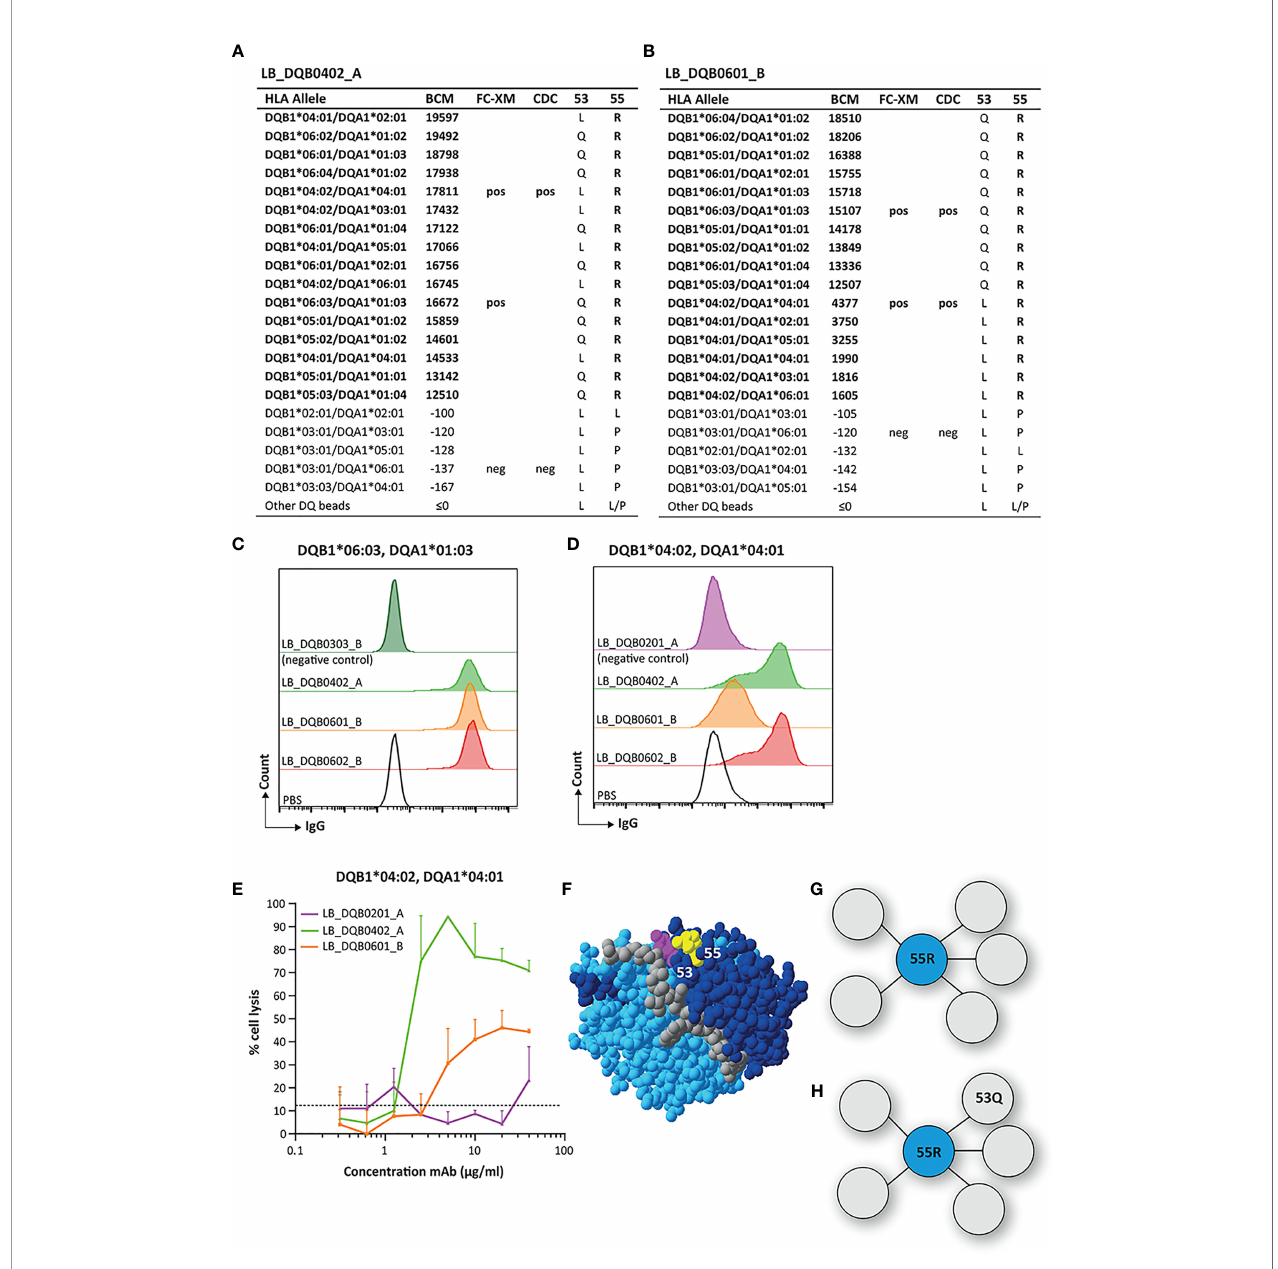
FIGURE 6 | Reactivity analysis of monoclonal antibodies LB_DQB0402_A and LB_DQB0601_B. (A) Comparison of the amino acid positions of interest of the HLA- DQB1 alleles on the reactive beads in the single antigen bead assay and a selection of the nonreactive HLA-DQB1 alleles for LB_DQB0402_A and LB_DQB0601_B (B) . Flow cytometry crossmatches with EBV-LCLs showed a higher binding strength of mAb LB_DQB0601_B for DQB1*06:03-expressing cells (C) than DQB1*04:02-expressing cells (D) . (E) LB_DQB0402_A induced a higher percentage of complement dependent cell lysis than LB_DQB0601_B for DQB1*04:02- expressing cells. (F) Locations of amino acid 53Q (magenta) and 55R (yellow) are indicated on the crystal structure of DQB1*06:02/DQA1*01:02 (PBD: 1UVQ). The b chain is depicted in dark blue, the a chain in light blue, and the peptide in grey. (G) Schematic representation of the footprint of mAbs LB_DQB0402_A and LB_DQB0602_B interacting with functional epitope 55R (cyan). (H) Schematic representation of the antibody footprint of LB_DQB0601_B that has a stronger binding to the functional epitope 55R (cyan) when additional amino acid 53Q (grey) is present. Monoclonal antibody concentrations used for testing were 20 µg/ml for single antigen bead assay and FC-XM and 0.3125 - 0.625 - 1.25 - 2.5 - 5 - 10 - 20 - 40 µg/ml for CDC. BCM, background corrected mean fl uorescence intensity; FC-XM, fl owcytometric crossmatch; CDC, complement dependent cytotoxicity; pos, positive; neg, negative; PBS, phosphate-buffered saline;